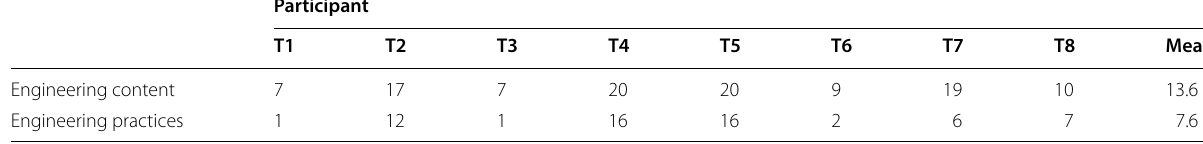
Scores for each category range from 0 to 20, with higher scores indicating a greater